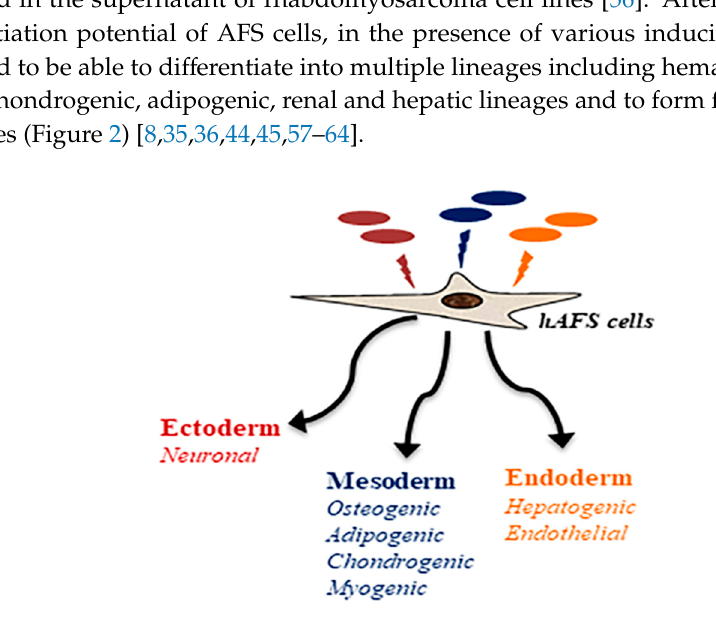
Figure 2. Multipotent differentiation potential of AFS cells.